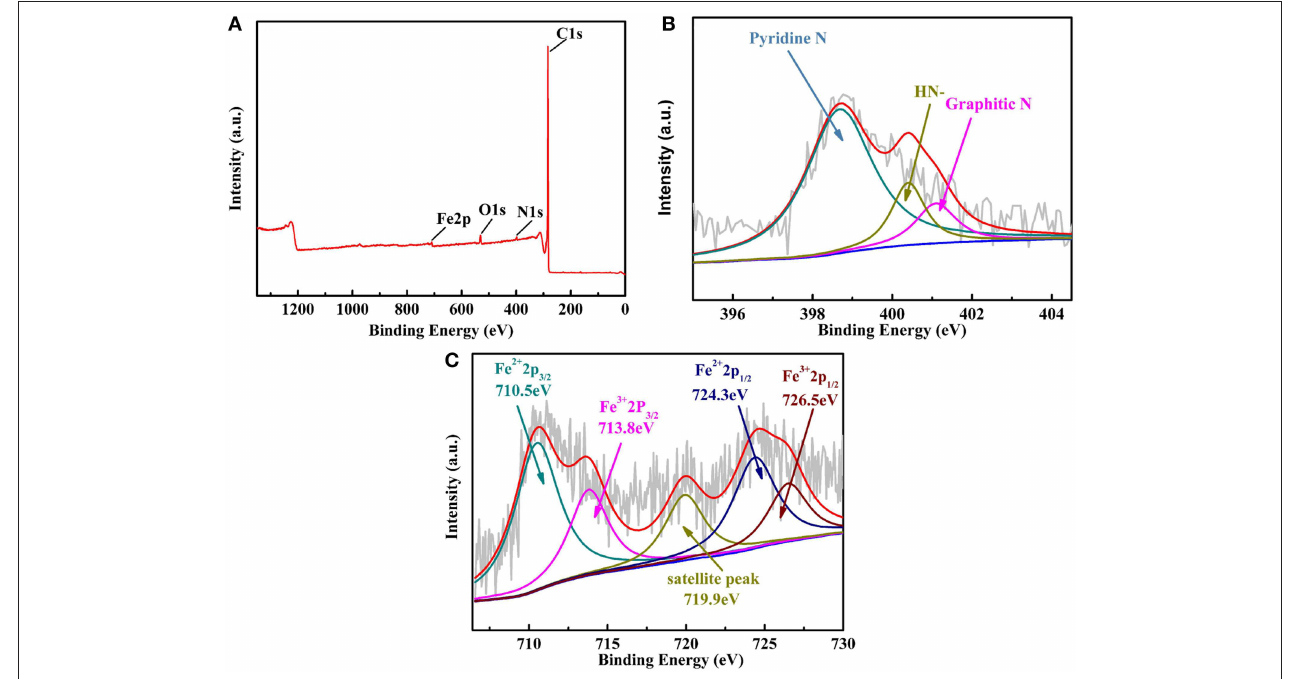
FIGURE 5 | The XPS survey scans of Fe-PIPhen/C (A) , the XPS spectrum of N 1s (B) and Fe 2p (C) for the Fe-PIPhen/C